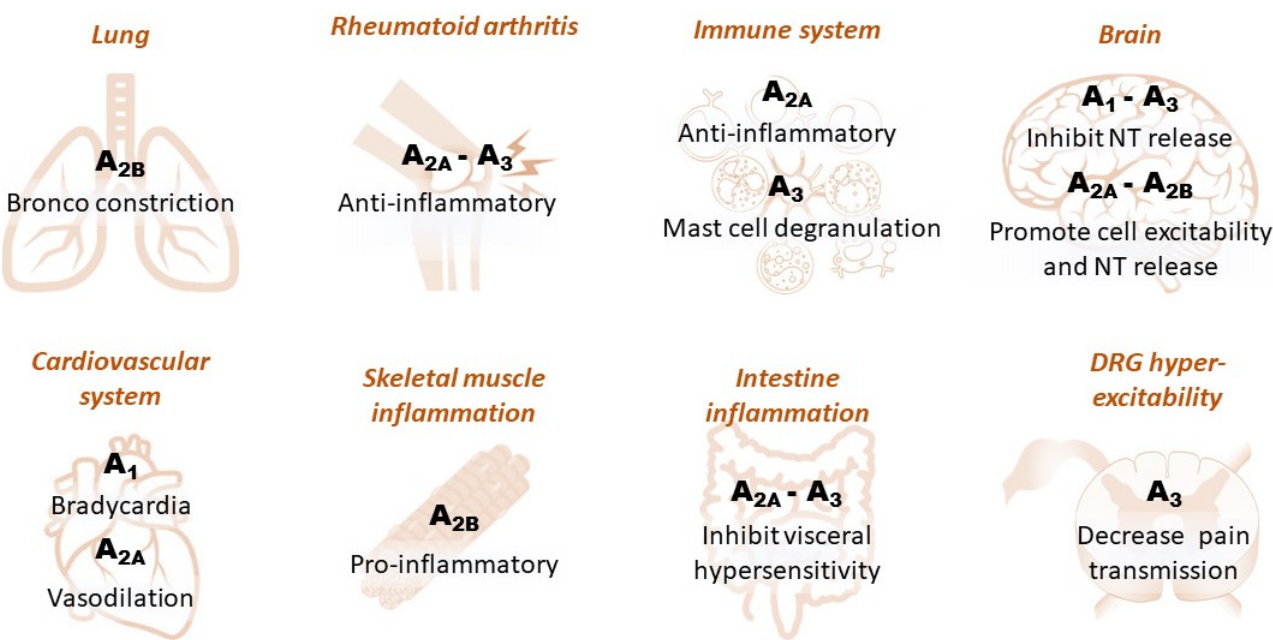
Figure 2. Schematic diagram illustrating the effect of different adenosine receptor subtypes in peripheral and central tissues. Dorsal root ganglia: